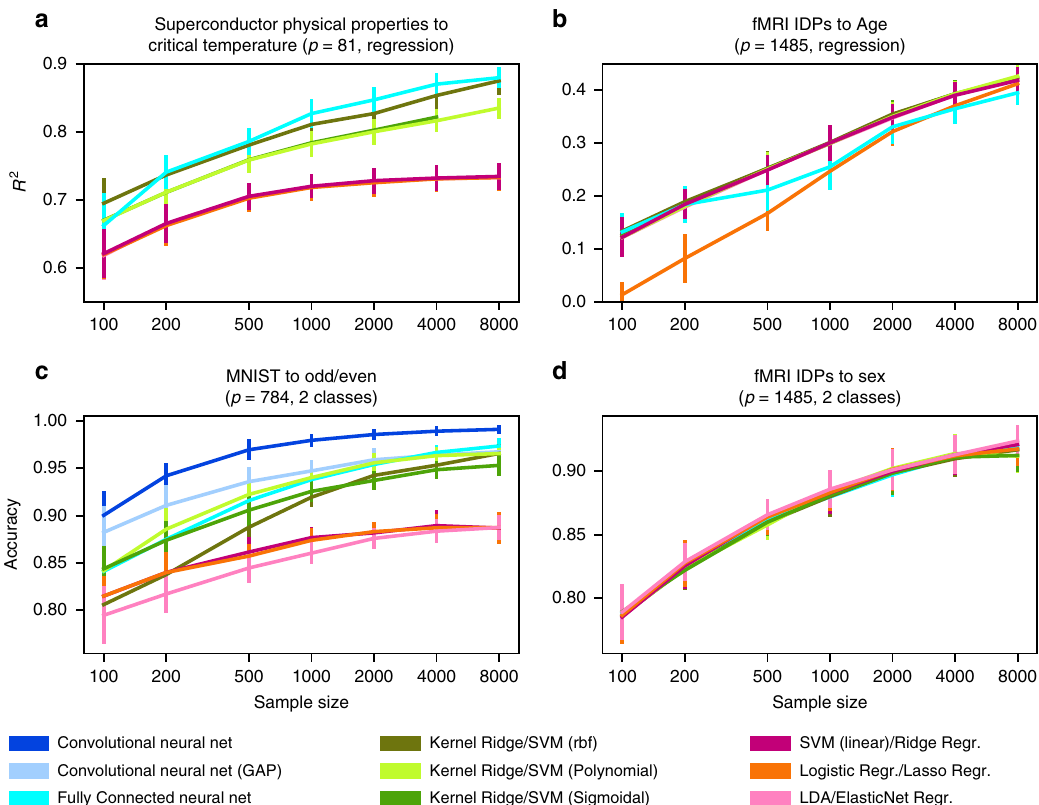
Fig. 4 Exploitable nonlinearity is apparent in different open datasets but not in functional brain images. To complement our classi fi cation of ten age/ sex-strati fi ed groups (Figs. 2 and 3), we decoupled the strati fi ed prediction goal by separately examining continuous age regression and categorical sex classi fi cation using linear (red tones), kernel (green tones), and deep (blue tones) models. In the superconductivity benchmark dataset ( a ), critical temperature was predicted based on 82 physical properties like thermal conductivity, atomic radius, and atomic mass 53 . Here, kernel and deep models clearly outperform linear models as measured by out-of-sample explained variance ( R 2 , coef fi cient of determination). In contrast, in age prediction based on functional brain scans ( b ), the best performing linear model (Ridge regression) has scaling behavior virtually identical to kernel and deep models. This age prediction using fMRI scans is conceptually similar to previous analyses on brain maturity that reported 55% explained variance on 238 subjects